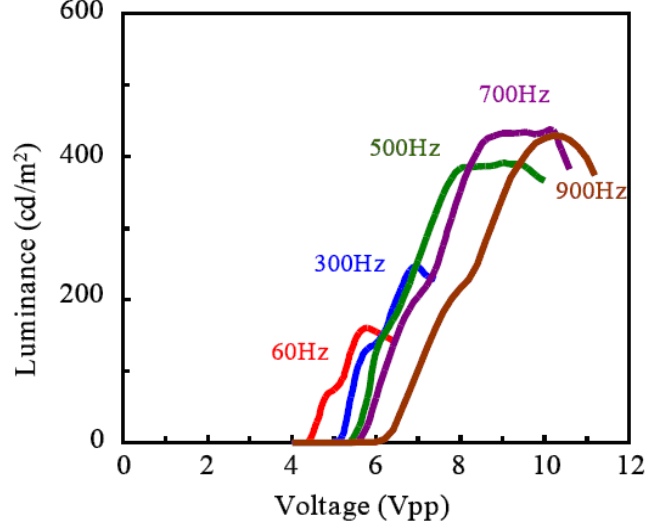
Figure 8. Frequency dependence of luminance characteristic to the voltage